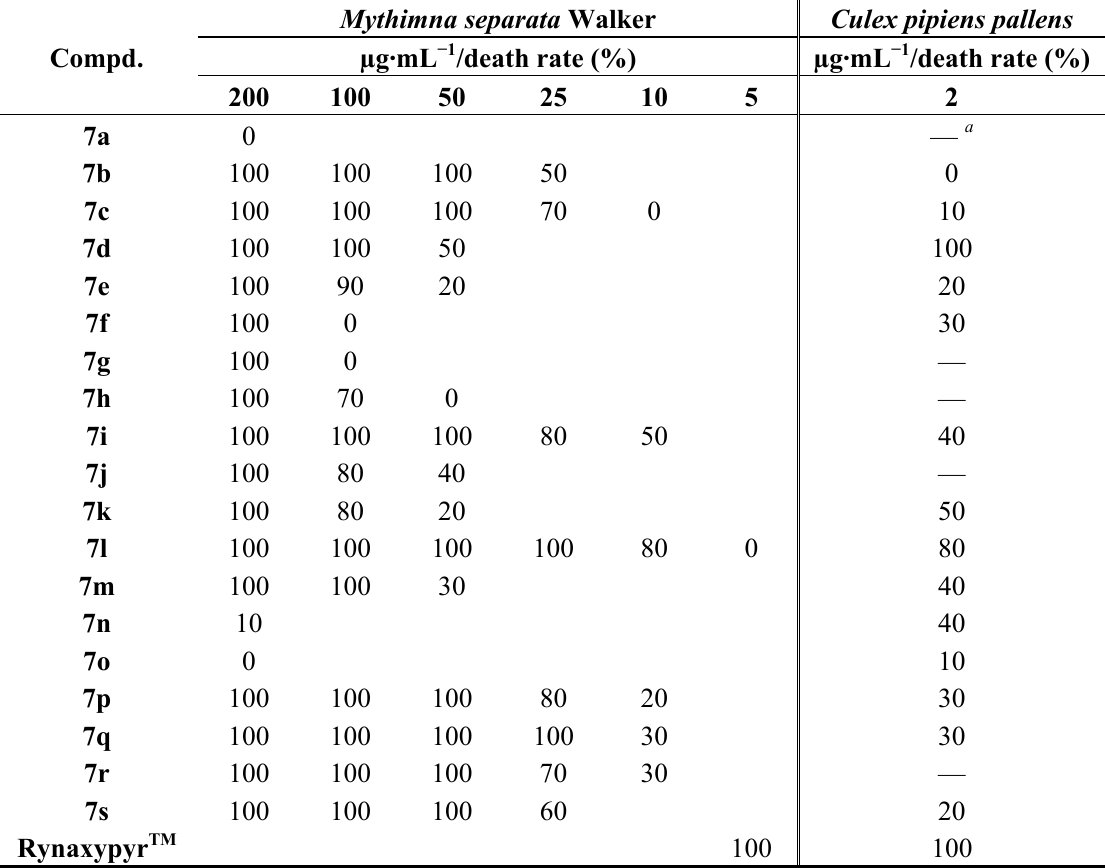
Table 2. Insecticidal activity against Mythimna separata Walker and Culex pipiens pallens of title compounds